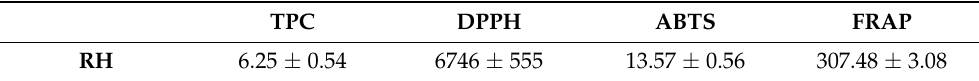
Table 4. Total Phenols Content (TPC), expressed as mg GAE 100 mL − 1 , and the antioxidant capacity of RH in three different tests: DPPH, ABTS, and FRAP. Antioxidant values are expressed as µ M of Trolox Equivalent 100 mL − 1 of RH used in the